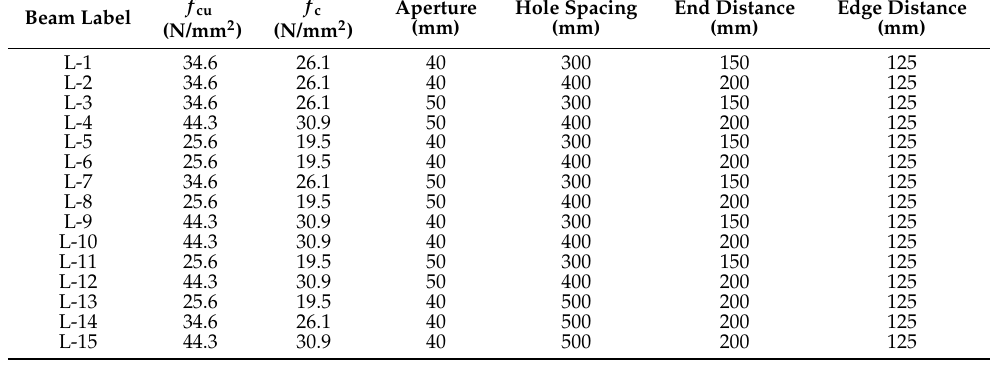
Figure 2. Reinforcements of beams. Figure 3. Examples of beams with ( a ) 300 mm and ( b ) 400 mm hole spacing. Table 2. Main design parameters of the specimens.